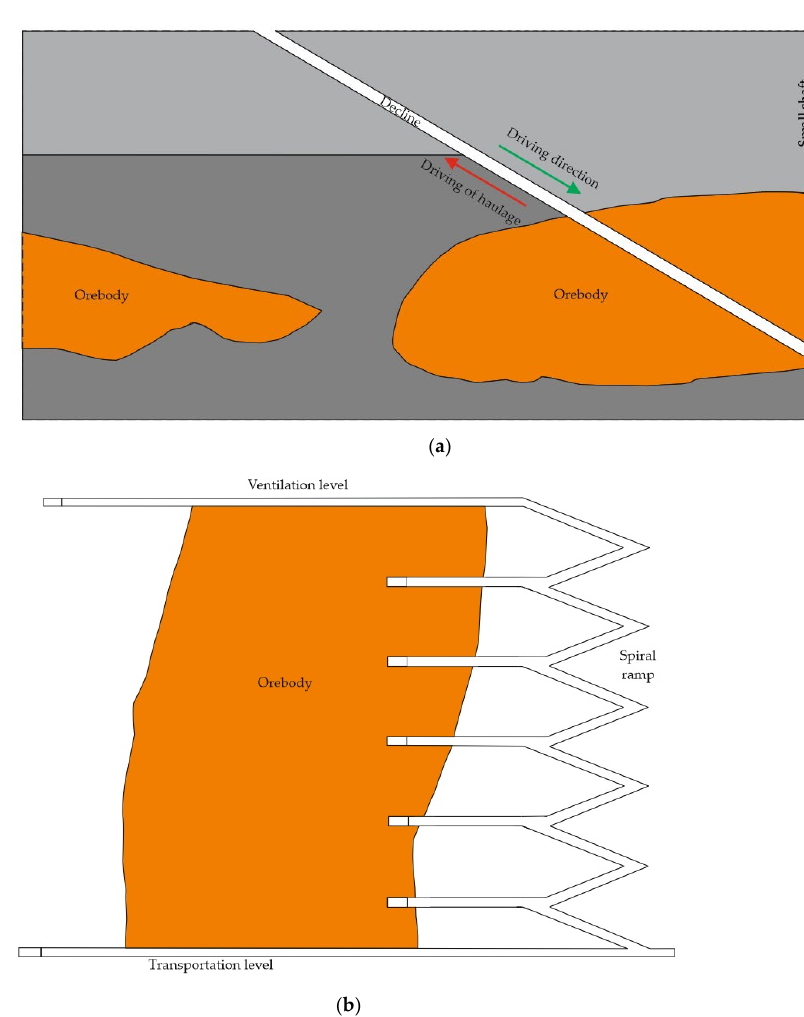
Figure 6. Access by means of decline: ( a ) With constant inclination; ( b ) Spiral ramp.